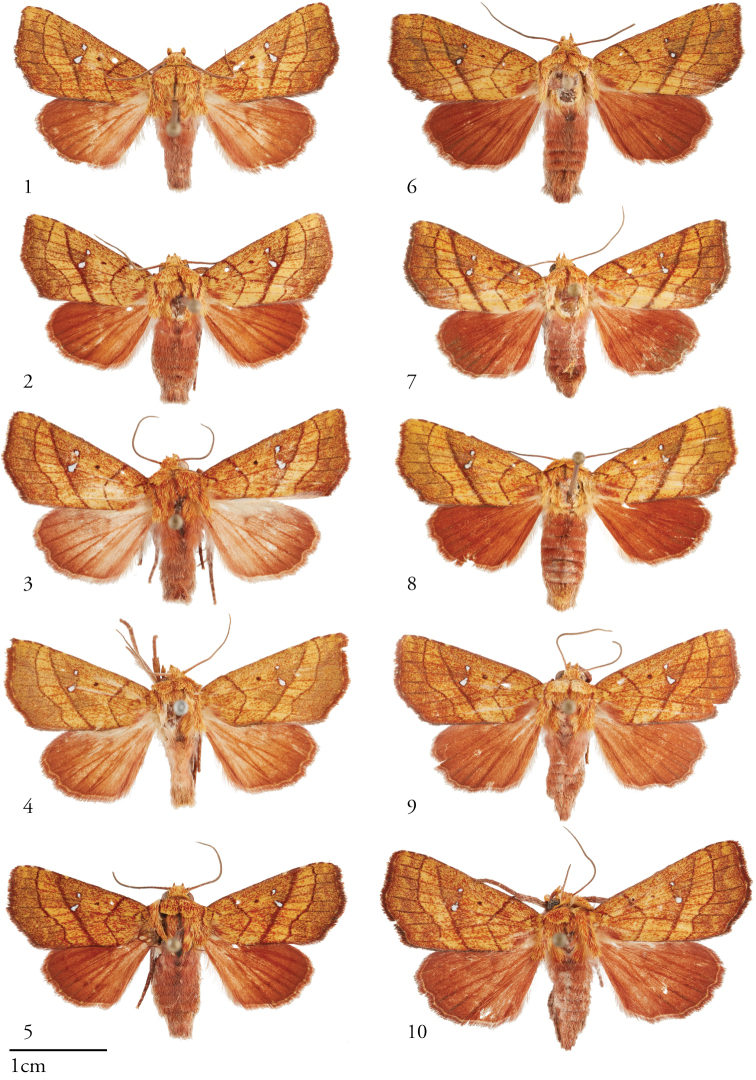
Dorsal habitus of Apricapatula, males (left, 1–5) and females (right, 6–10). 1USNMENT01463599, 05-SRNP-48763 2USNMENT01463665, 05-SRNP-2726 3USNMENT014638944USNMENT014638935USNMENT01463658, 14-SRNP-80751 6USNMENT01463798, 10-SRNP-44267 7USNMENT01463999, 11-SRNP-42773 8USNMENT01463895, 07-SRNP-46182 9USNMENT01463671, 08-SRNP-104889 10USNMENT01463571.